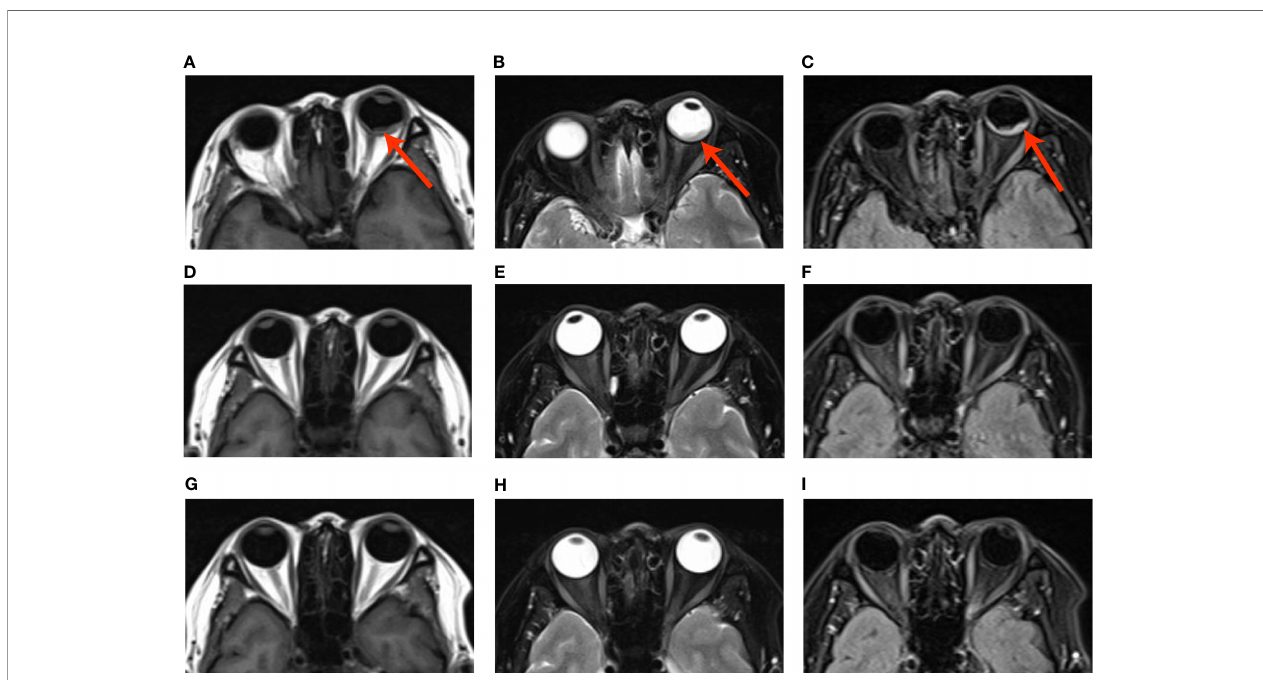
FIGURE 2 | (A – C) Basal MRI-scan of the eyes, (D – F) reduction of the abnormal tissue in the left eye in 6th month crizotinib theraphy; (G – H) . No progression of malignancy on the 14th month crizitinib